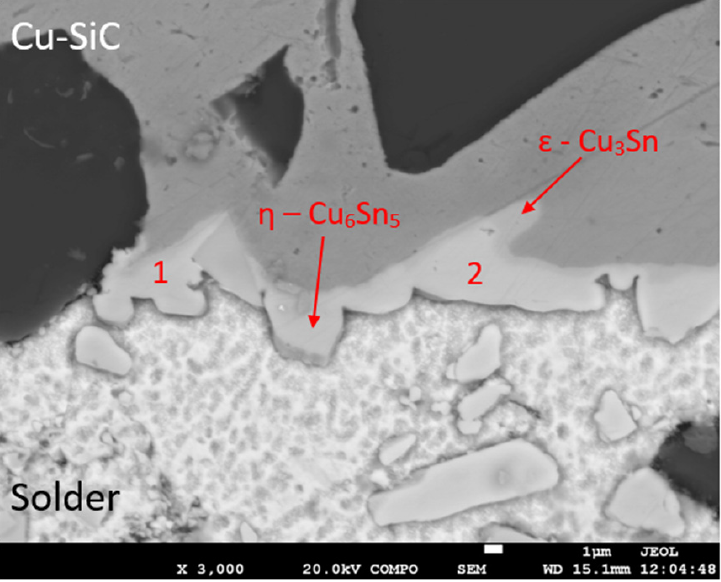
Figure 21 . Representation of the boundary in the Cu–SiC/Sn5Sb3Ti joint . Figure 21. Representation of the boundary in the Cu–SiC/Sn5Sb3Ti joint.